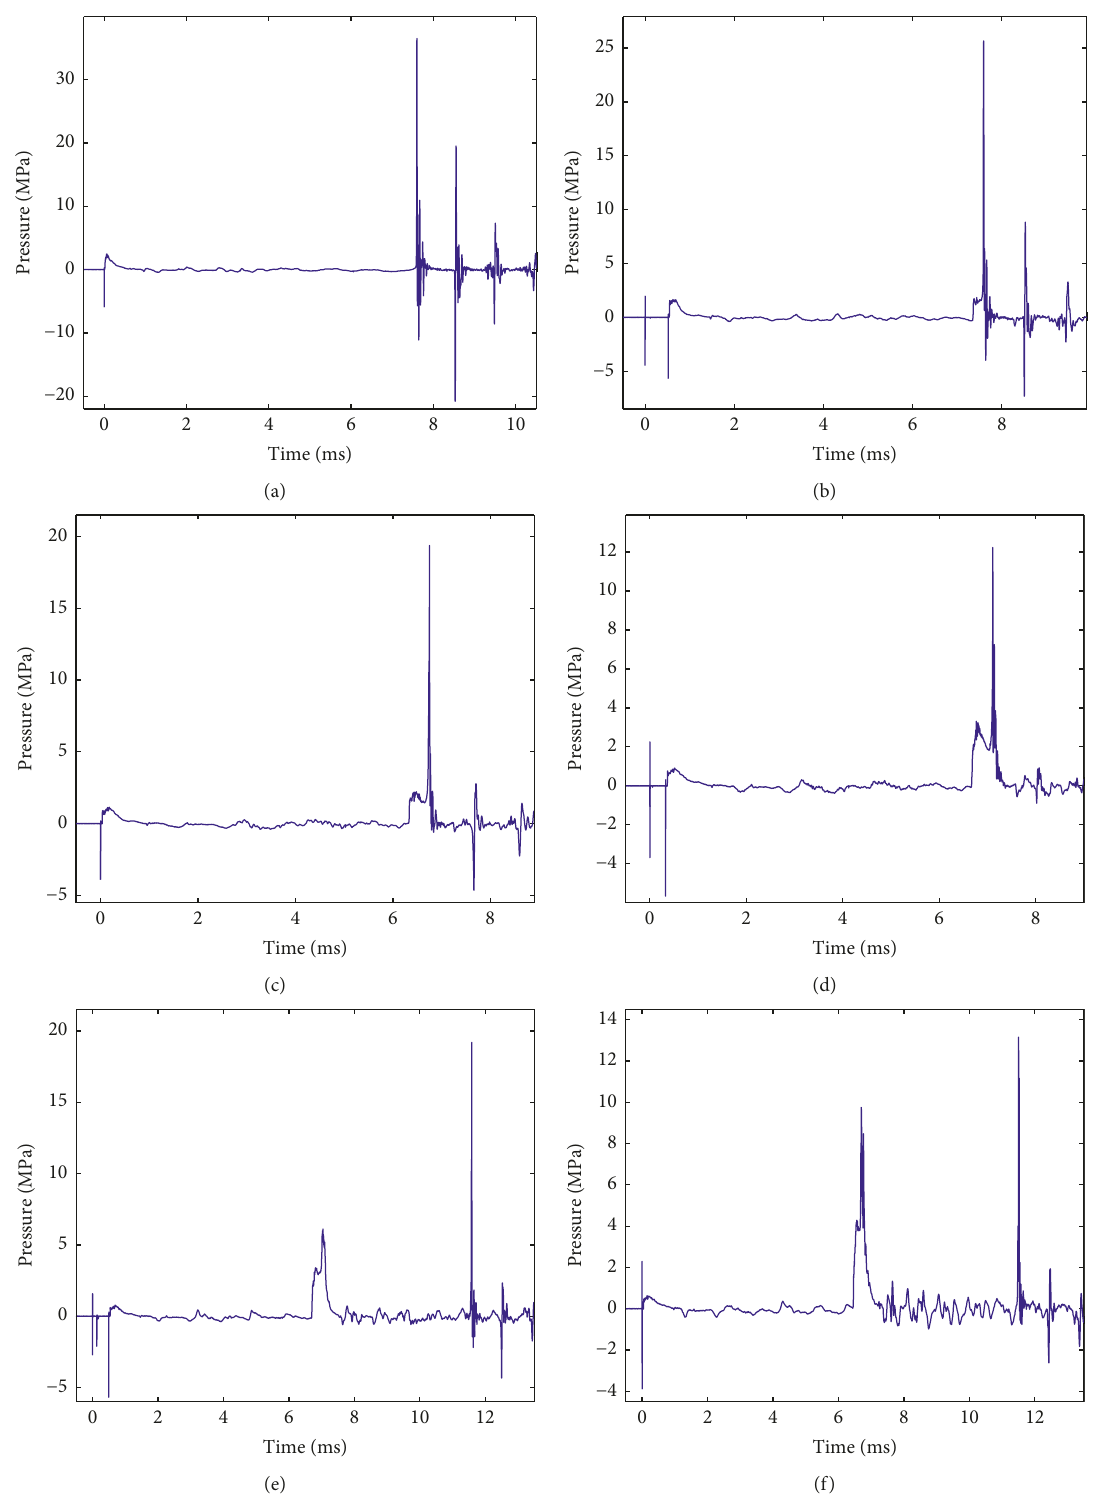
Figure 12: Pressure-time profile recorded by HPB with a 5mm, 10mm, 15mm, ... , and 30mm standoff. (a) 5mm standoff. (b) 10mm standoff. (c) 15mm standoff. (d) 20mm standoff. (e) 25 mm standoff. (f) 30mm